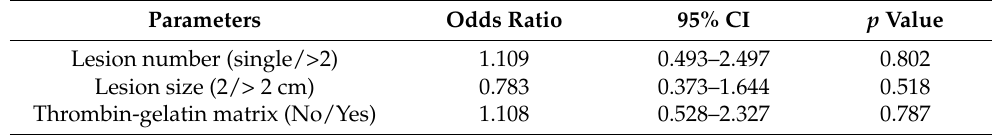
Table 3. Result of factors affecting Hematoma.